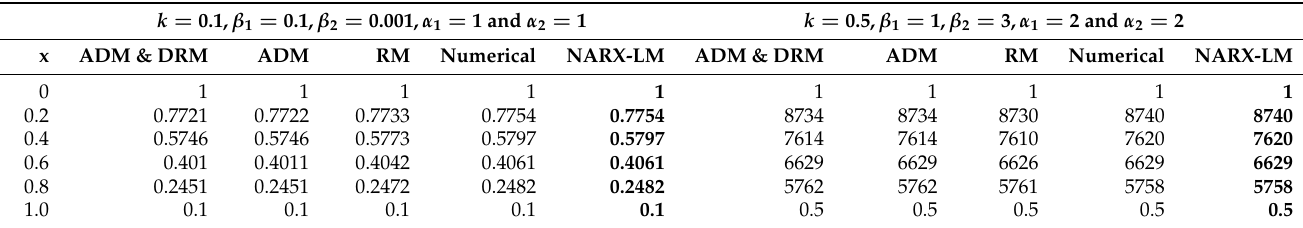
Table 1. Comparison of the solutions obtained by the NARX-LM algorithm with the numerical results, NM, ADM, and DRM for the steady state concentration of CO 2 .